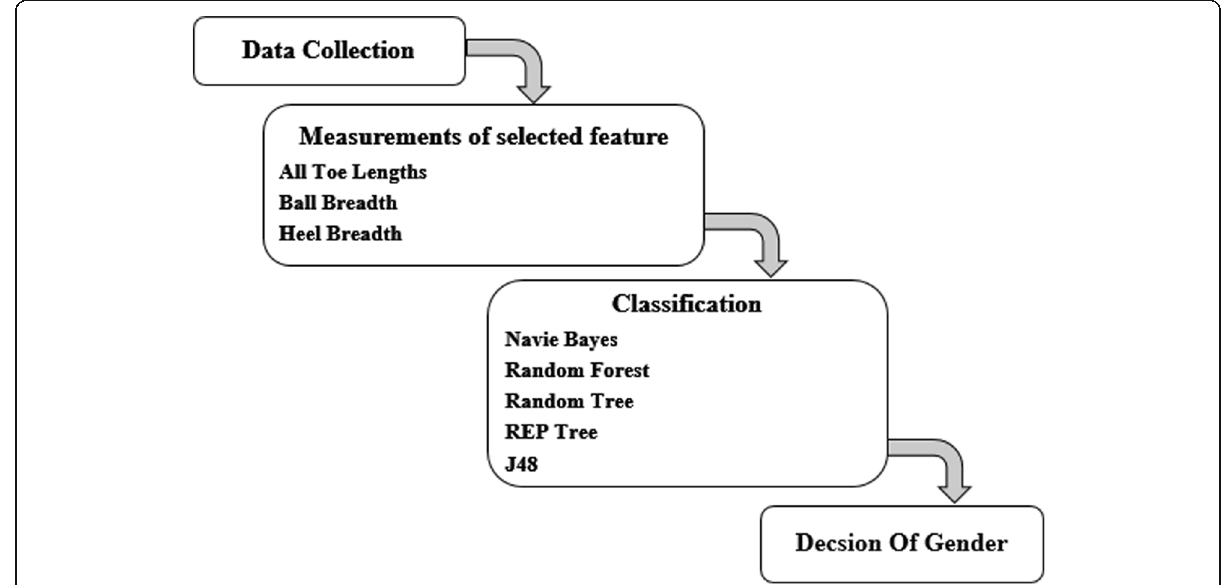
Fig. 2 Methodology proposed by the present